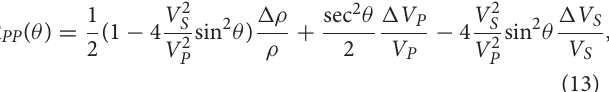
rock based on the interpretation of the P-wave impedance